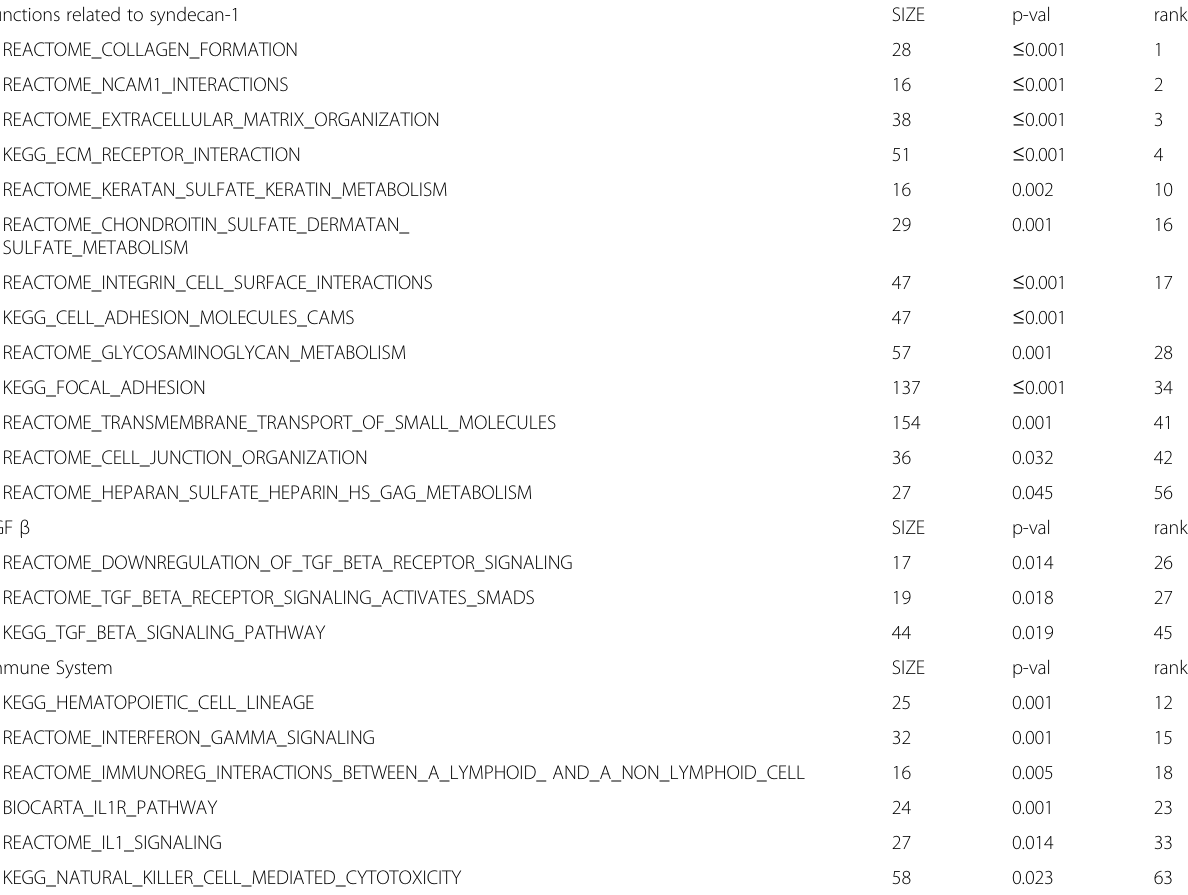
Table 4 Categories of top enriched pathways identified by Gene Set Enrichment Analysis (GSEA) of proteomic dataset Functions related to syndecan-1